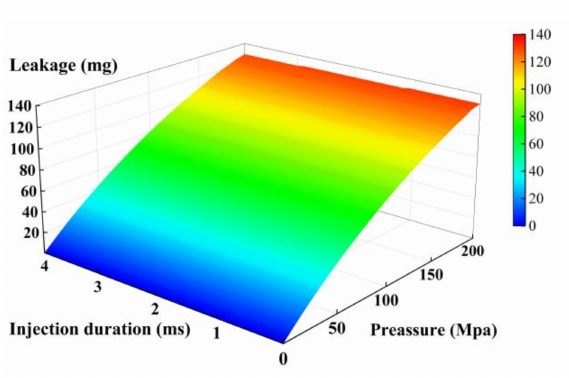
Figure 8. Characteristic data of injector leakage.